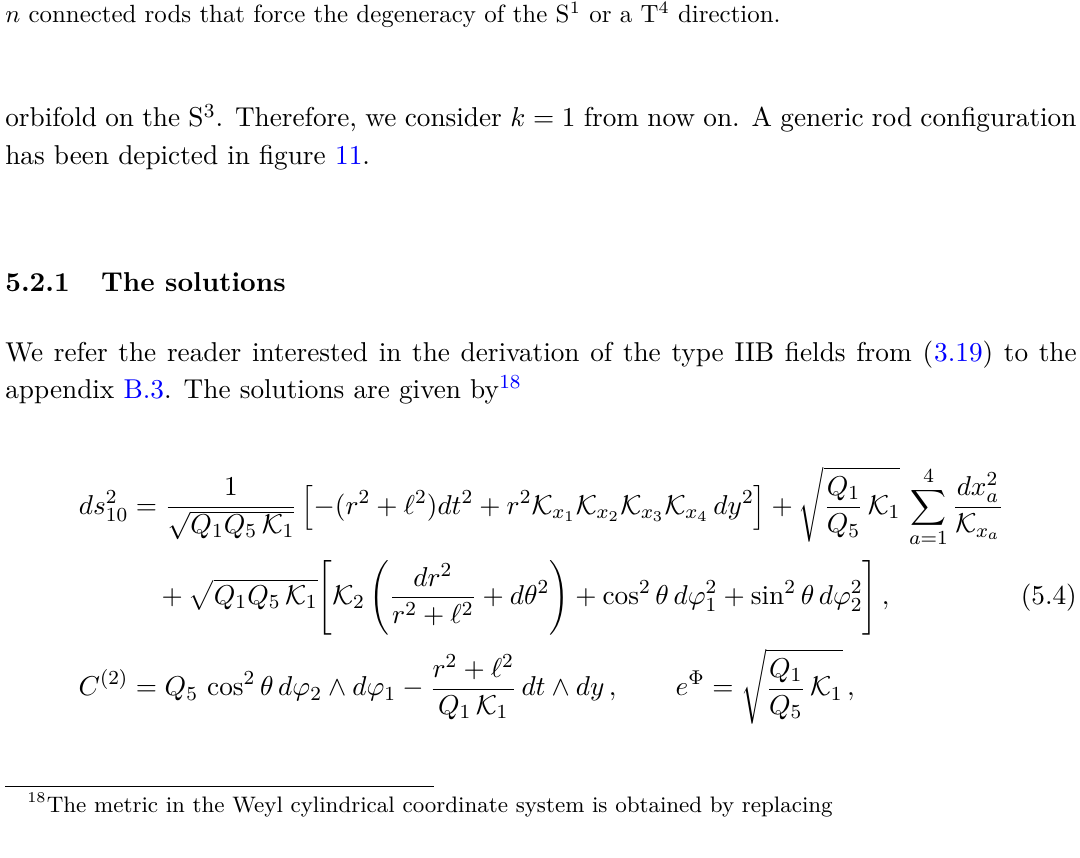
Figure 11 . Rod diagram of the shrinking directions on the z -axis after sourcing the solutions with n connected rods that force the degeneracy of the S 1 or a T 4